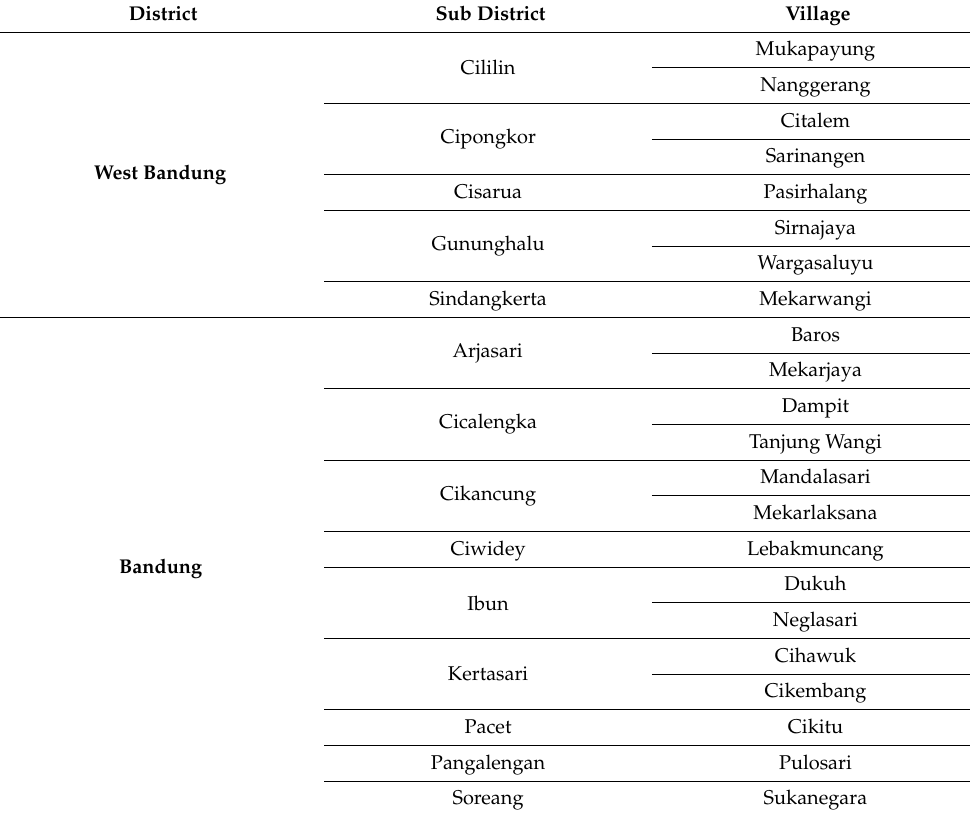
Table A1. Location of the